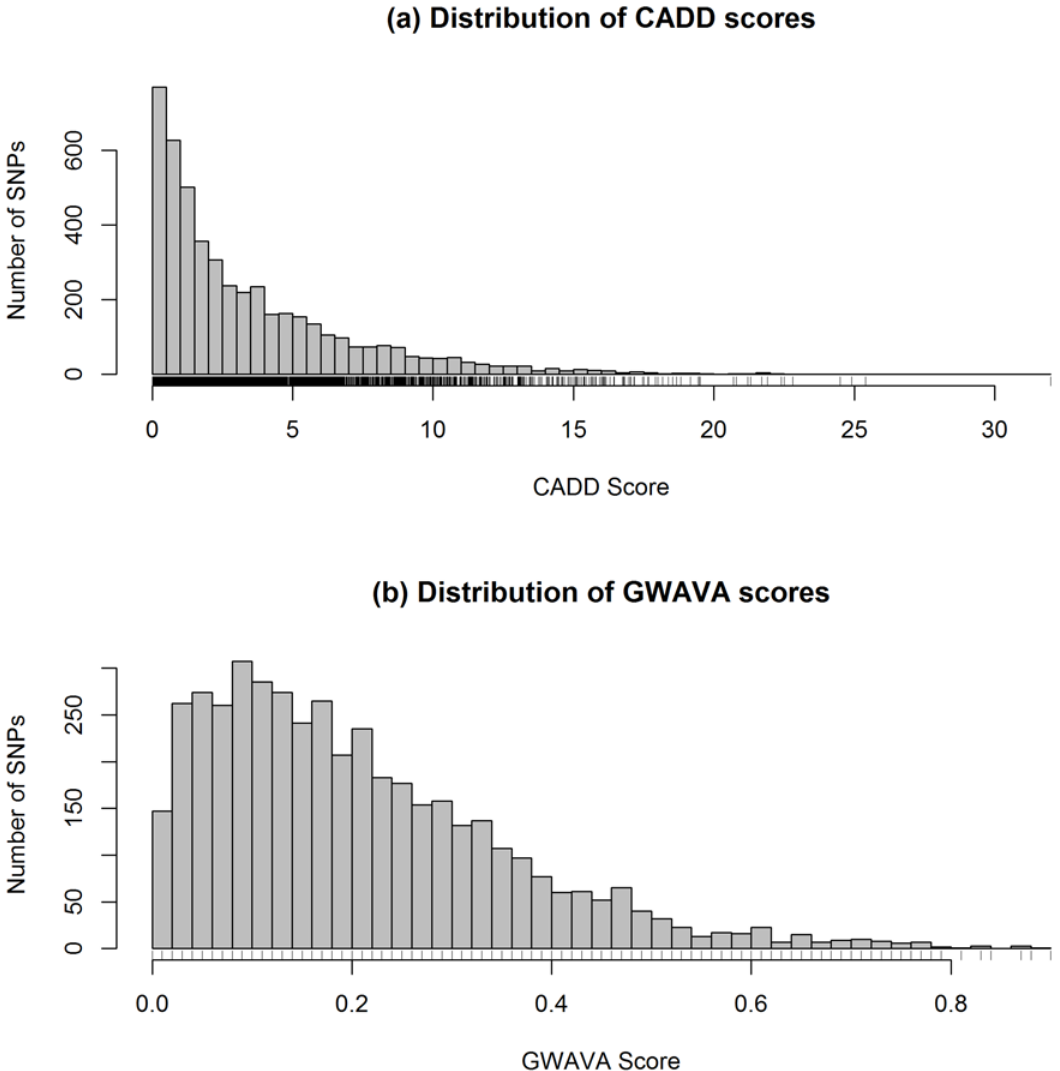
Fig 2. Distribution of (a) CADD and (b) GWAVA scores. Histograms are drawn taking CADD and GWAVA scores of all the variants (lead GWAS SNPs and LD variants) after removing the missing values. Here n = 4781 for CADD and n = 4460 variants for